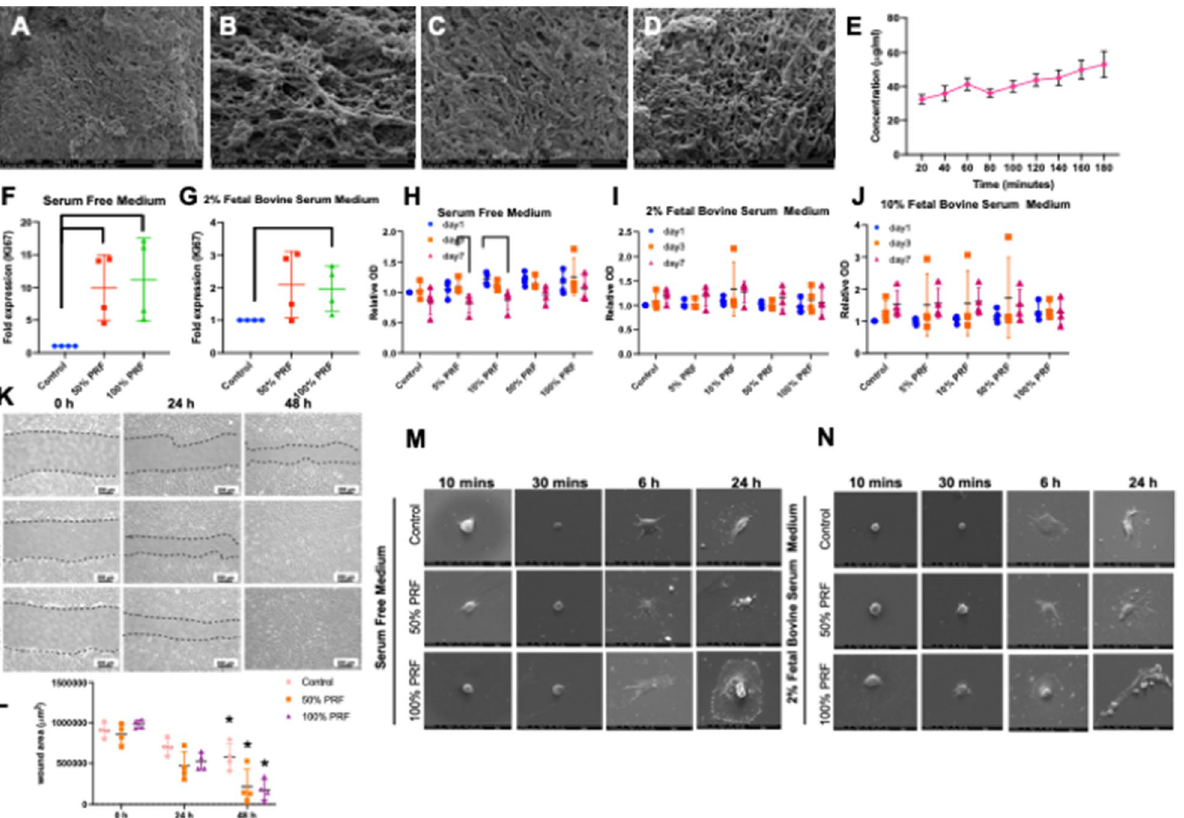
Figure 7. Frozen Thai bubaline blood derived platelet rich fibrin (PRF) also promoted cell proliferation, migration, and spreading. Ultrastructure of frozen Thai bubaline blood derived PRF was examined using scanning electron microscope ( A – D ). The in vitro degradation was determined using BCA assay ( E ). KI67 mRNA expression was evaluated using real-time PCR ( F – G ). Cell viability at day 1, 3 and 7 was determined using MTT assay ( H–J ). Bars indicated the statistically significant difference. (Mann Whitney U test, p < 0.05). The representative images of cPDLs migration were demonstrated ( K ). The graph demonstrated the scratch defect area determining by ImageJ software ( L ). Asterisks indicated the statistically significant difference compared with the same condition at 0 h (Kruskal–Wallis test with Dunn’s multiple comparisons test, p < 0.05). Representative micrographs demonstrated cell morphology at different time point upon exposed to different concentration of frozen Thai bubaline blood derived PRF ( M and N